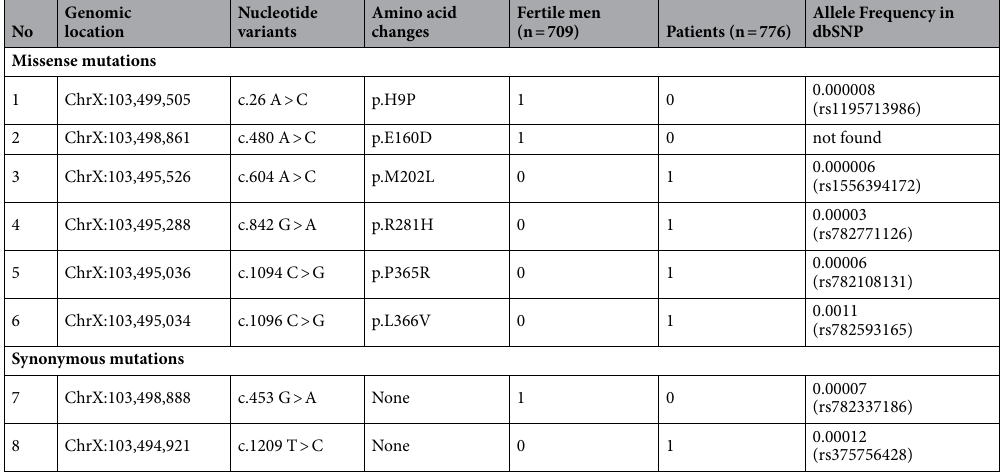
Nucleotide changes Sample IDs Age